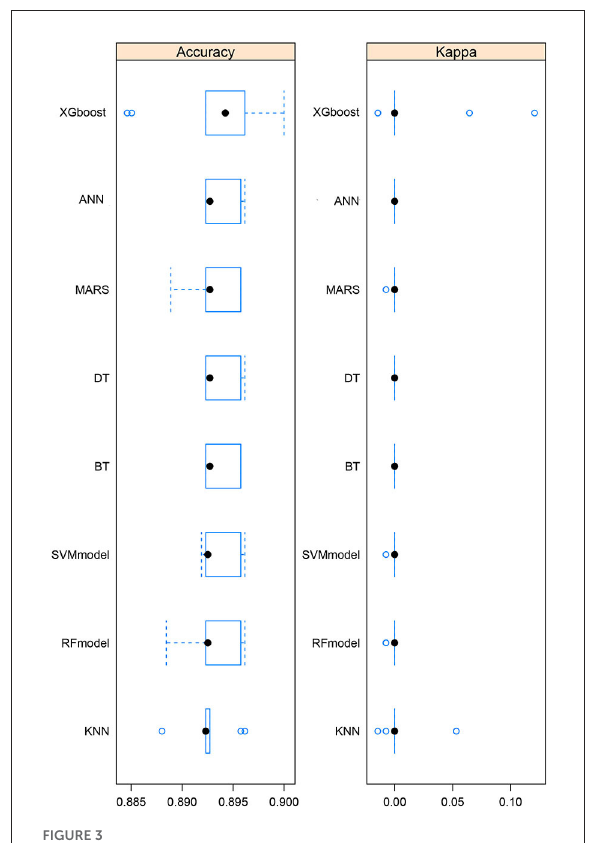
FIGURE3 Comparison among 8 machine learning algorithms. The accuracy and kappa value of each algorithm are shown.